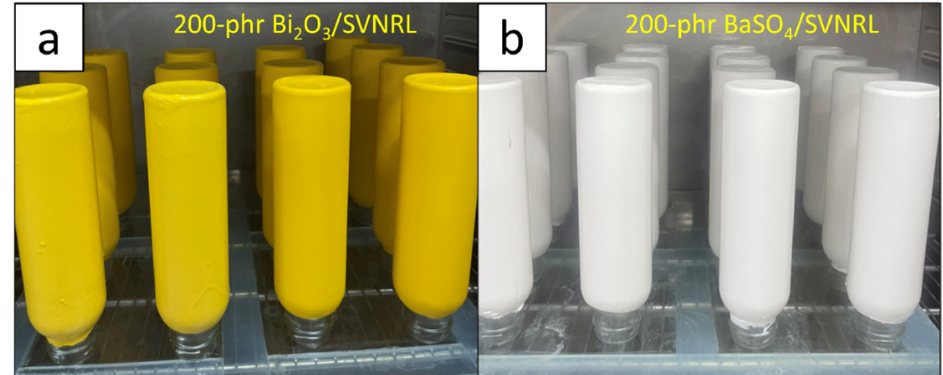
Figure 2. Images showing physical appearance and color of ( a ) nano-Bi 2 O 3 /SVNRL and ( b ) nano- BaSO 4 /SVNRL composites containing 200 phr of their respective fillers.